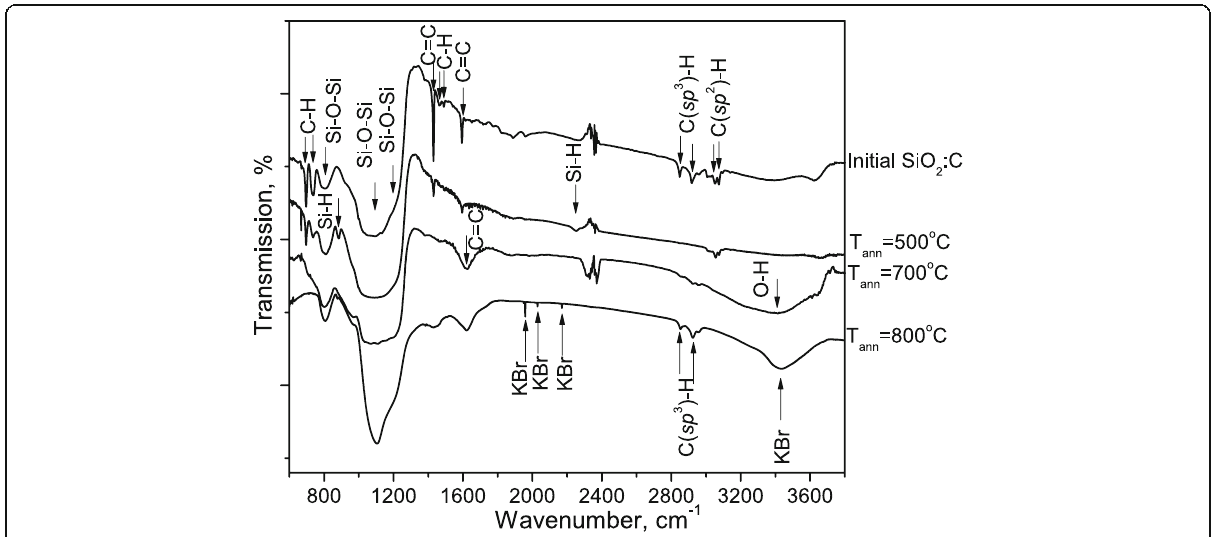
Fig. 1 The FTIR spectra of the initial and annealed SiO 2 :C